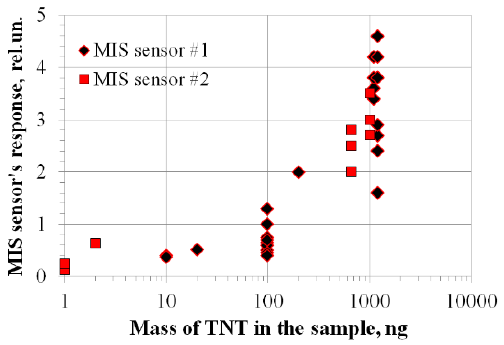
Figure 8. Calibration of a prototype detector using TNT samples of various weights.